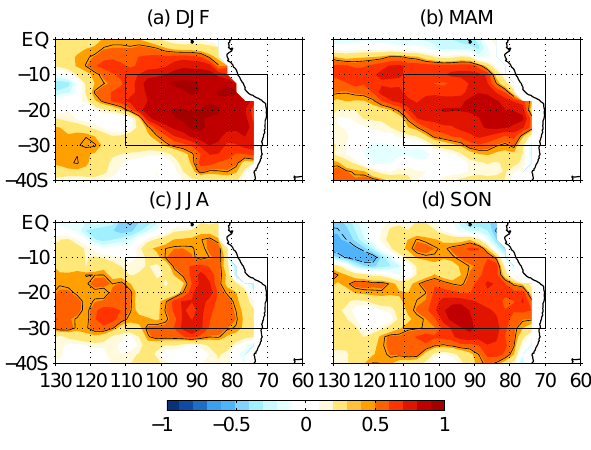
Fig. 3. Correlation of seasonal mean, area-averaged adjusted low cloud amount with adjusted low cloud amount at each grid point for season (a) DJF, (b) MAM, (c) JJA and (d) SON. Contour line denoting the 95% significance level using the Student-t test is high- lighted. The area of averaging is shown as a box, and is identical to the box in Fig. 1.